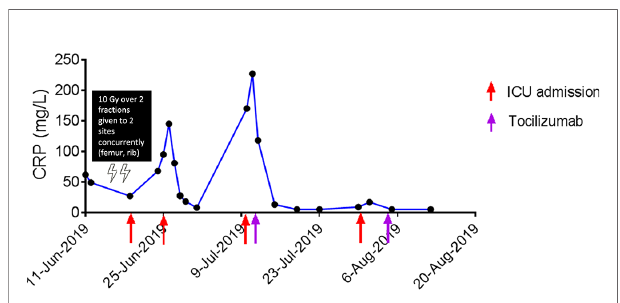
FIGURE 1 | Response to tocilizumab in a patient with CRS